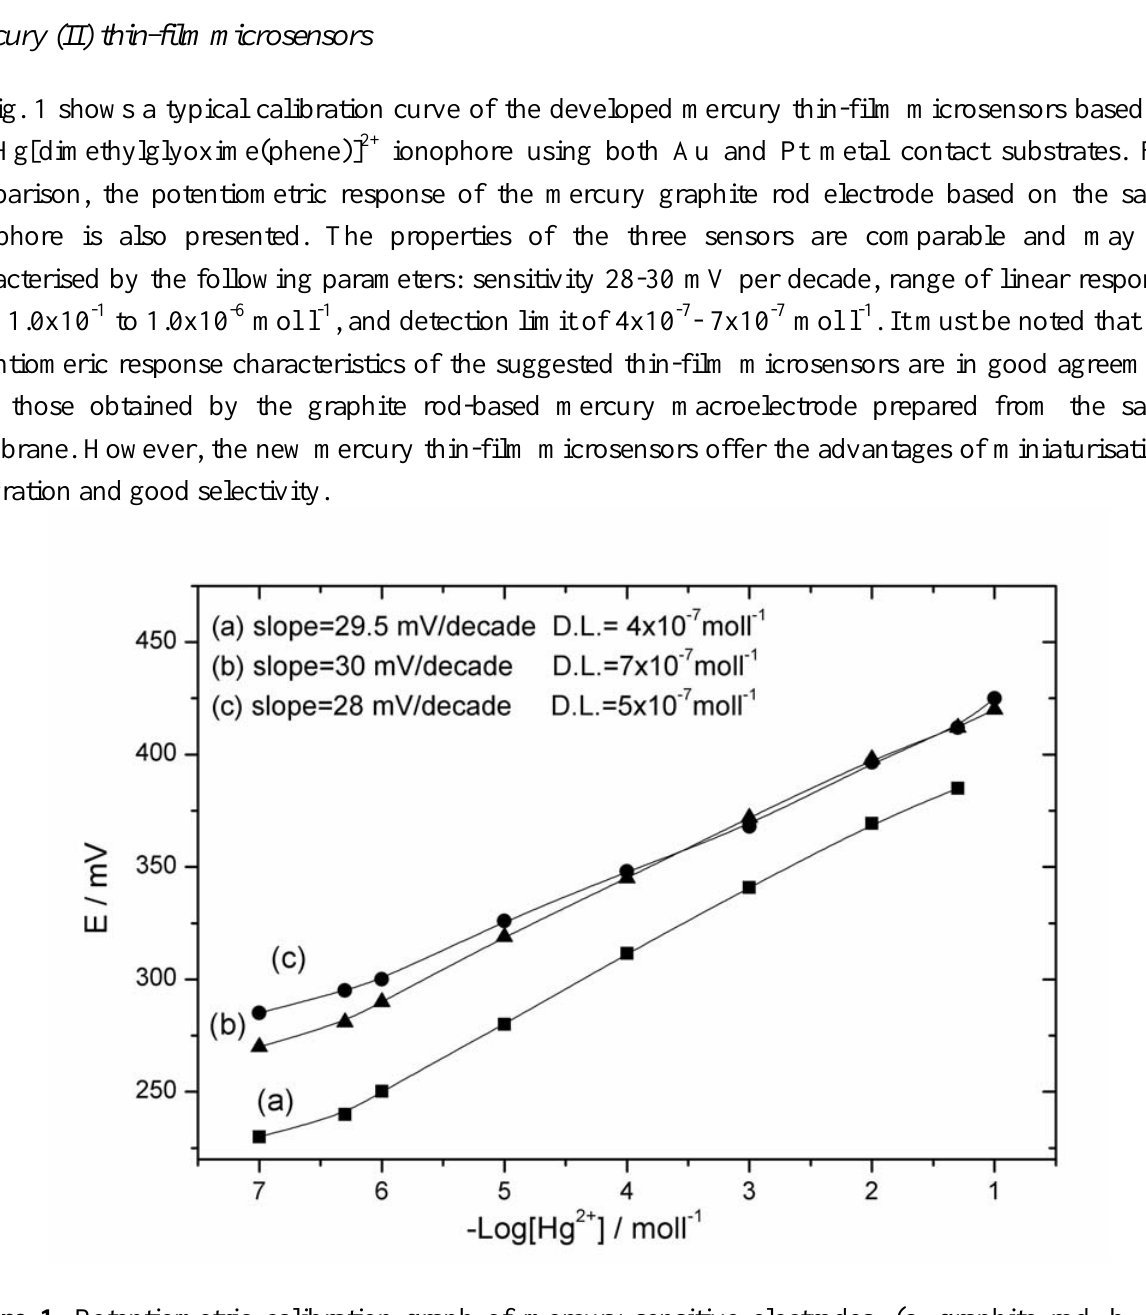
Figure 1. Potentiometric calibration graph of mercury-sensitive electrodes; (a: graphite rod, b: Au microsensor, c: Pt